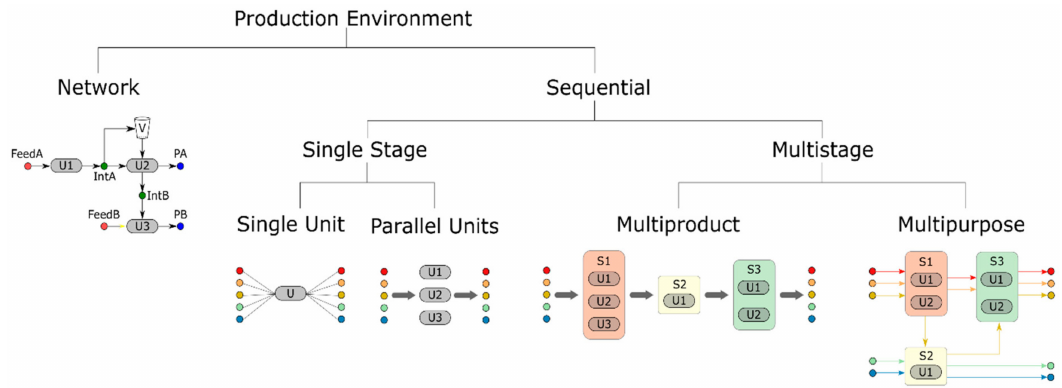
Figure 3. Categorization of scheduling problems based on the production